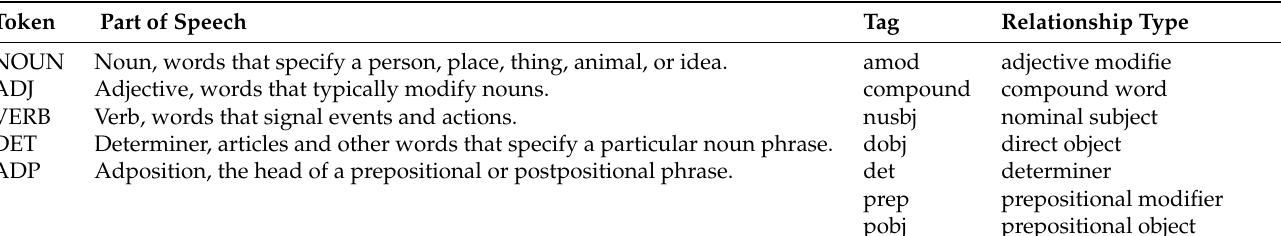
Figure 2. The example of the syntactic dependency tree. Table 1. Explanation of tokens and relationship type meanings mentioned in Figure 2.